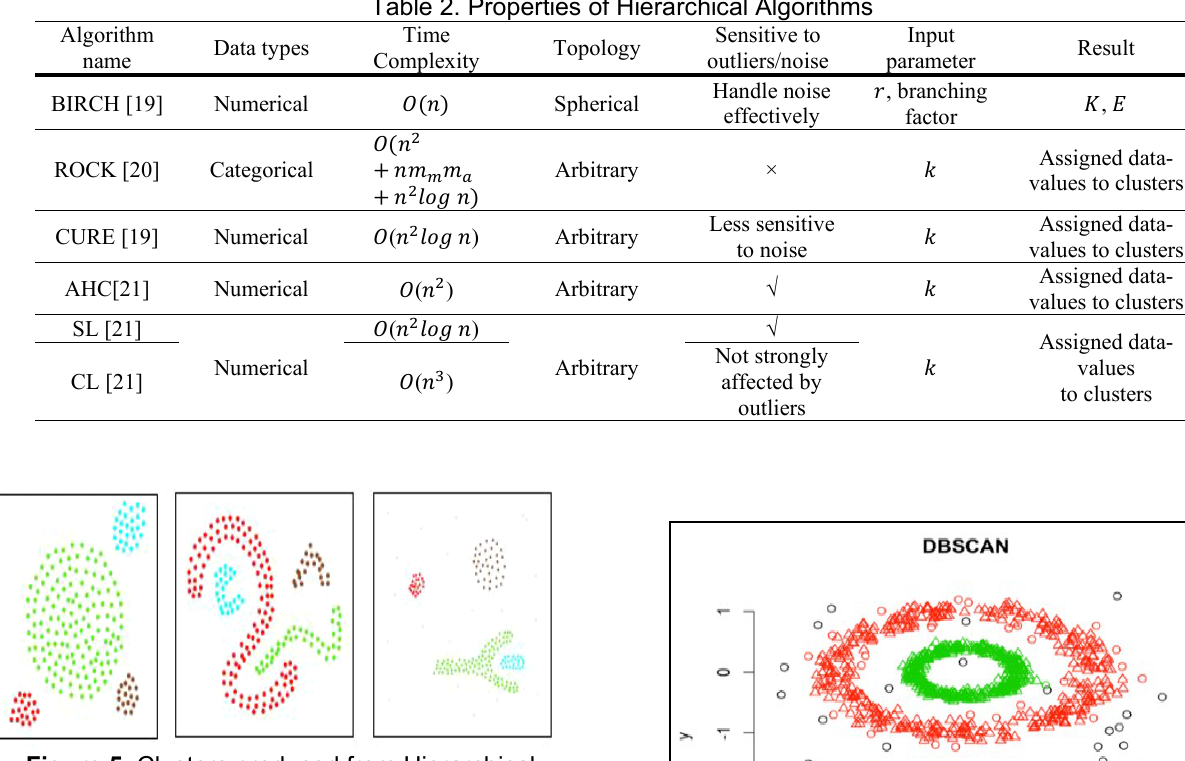
Figure 5. Clusters produced from Hierarchical algorithms